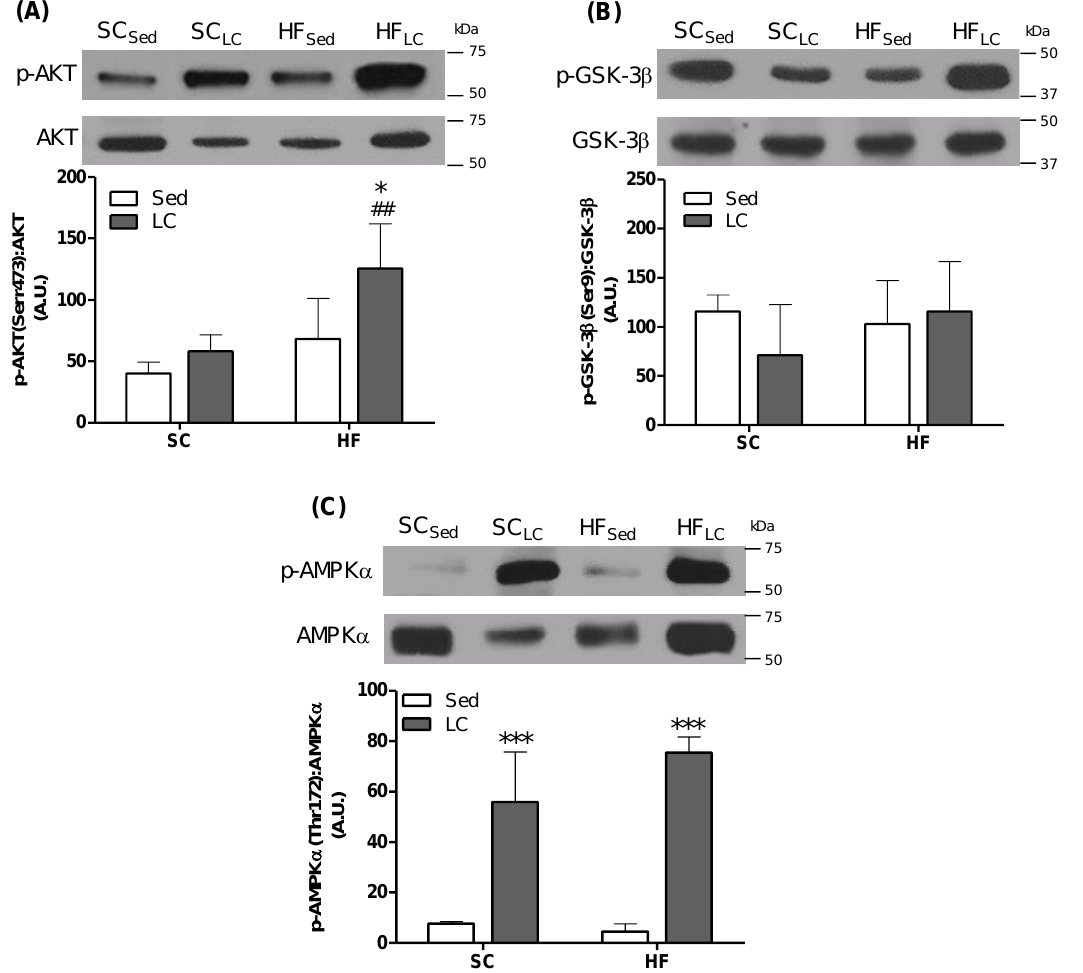
Figure 4. The effects of 8 weeks of LC on phosphorylation of AKT ( A ), GSK3β ( B ), and AMPKα ( C ) in the gastrocnemius muscles of mice fed either SC or HF diet. Endogenous control protein (GAPDH). Two-way ANOVA with Bonferroni posthoc test (n = 4). * p < 0.05, *** p < 0.001 vs. respec- tive sedentary (Sed) group; ## p <0.01 vs. respective SC group.